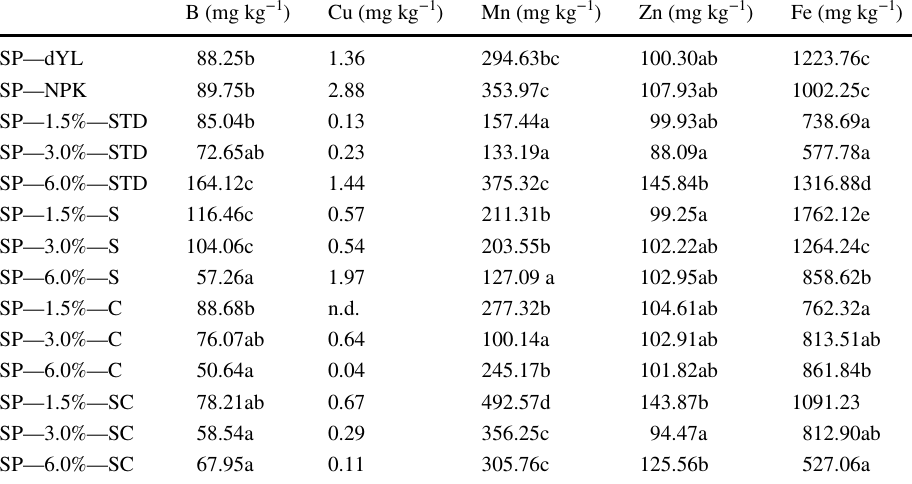
analysis (micronutrients) on sweet pepper leaves cultivated on different substrates (SP— STD, SP—S, SP—C and SP— SC), the reference sample (SP— NPK) and the control